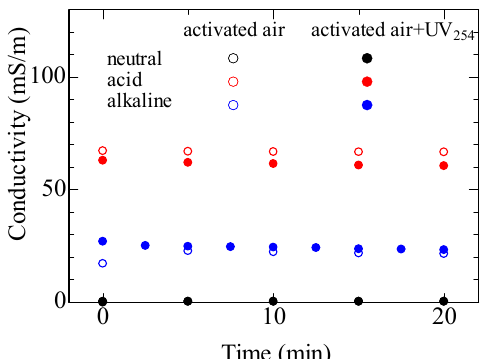
Fig. 5 Time evolution of electrical conductivity during microbubbling of activated air with or without UV irradiation.